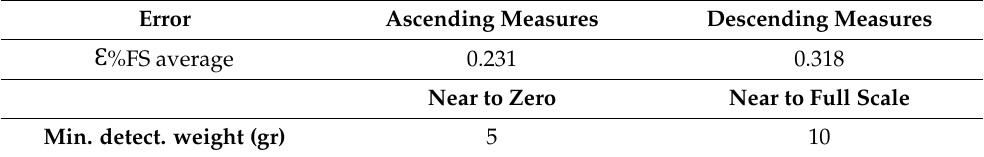
Table 1. Weight average error and minimum detectable weight of the Weight System.